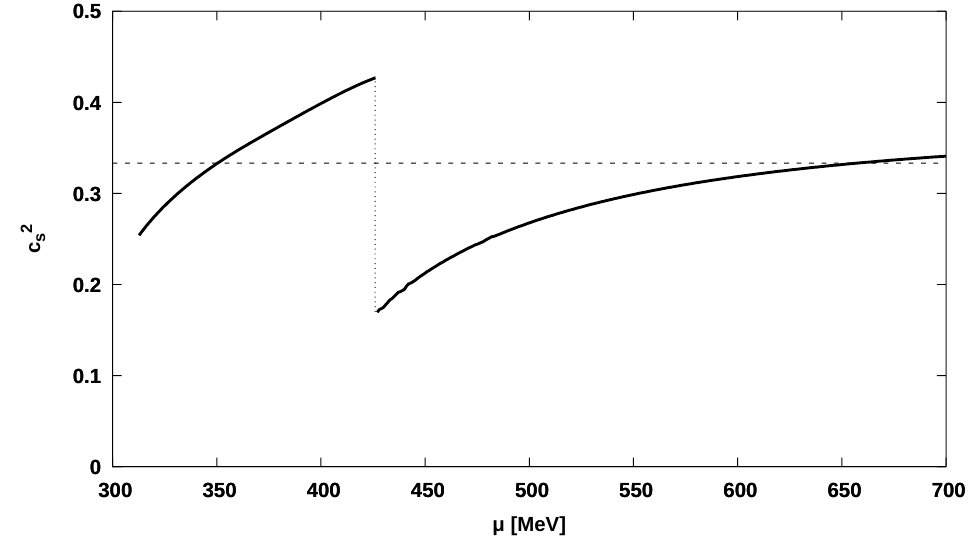
Figure 6 . Speed of sound at T = 0. The dashed horizontal line denotes the conformal